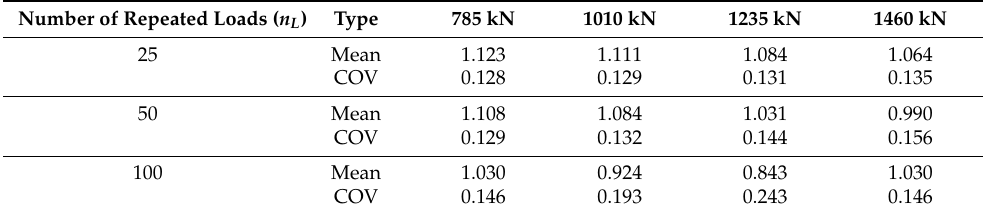
Table 23. Residual shear strength (normalized) after the repeated loads ( P u , r